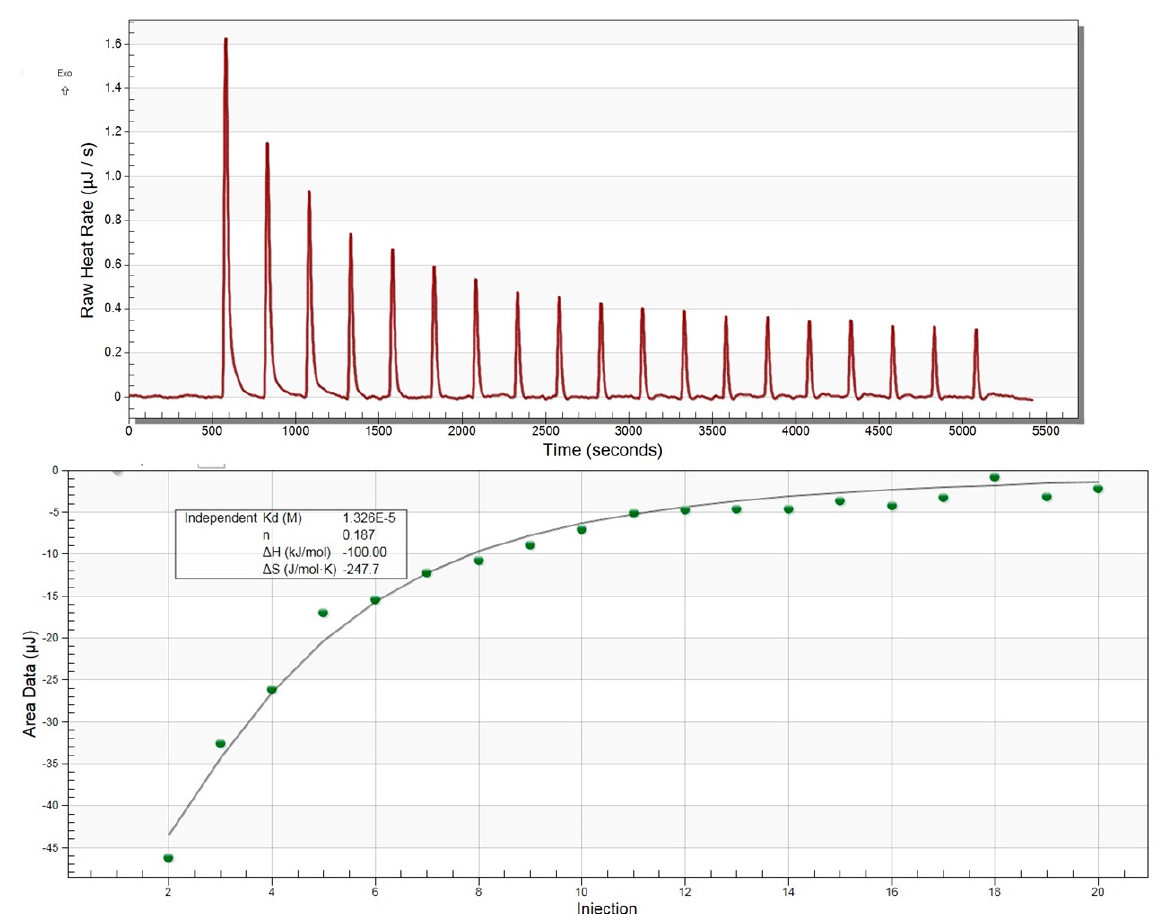
Figure 5. Isothermal titration calorimetry profile for ADP-ribose binding to MavL.